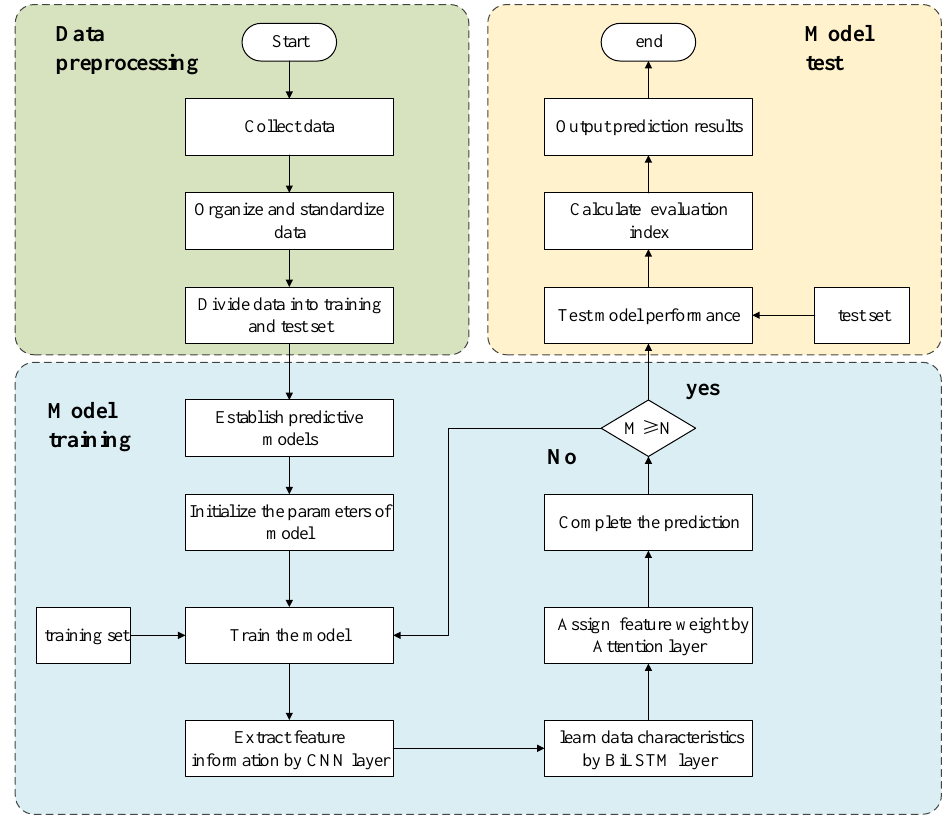
Figure 5. Prediction process of large-capacity lead – acid batteries SOH by CNN-BiLSTM-Attention Figure model.